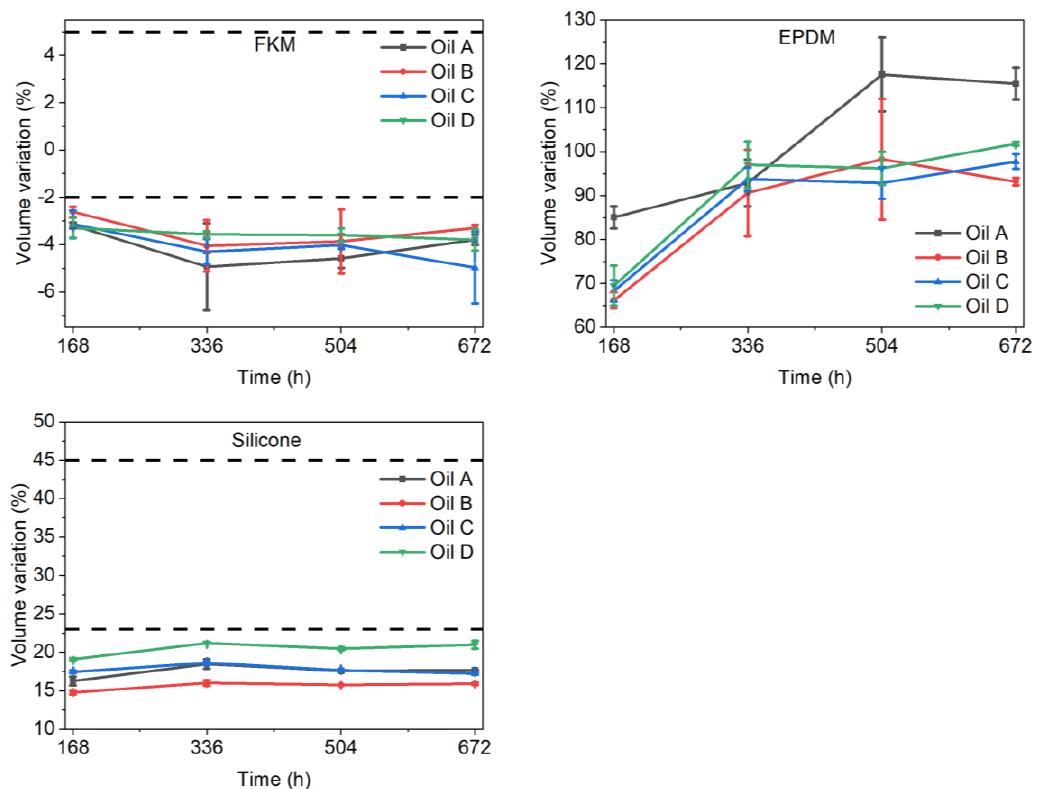
Figure 1. Changes in volume (expressed as the ratio of the volume variation to the initial volume) of the FKM, silicone, and EPDM after aging in oils A, B, C, and